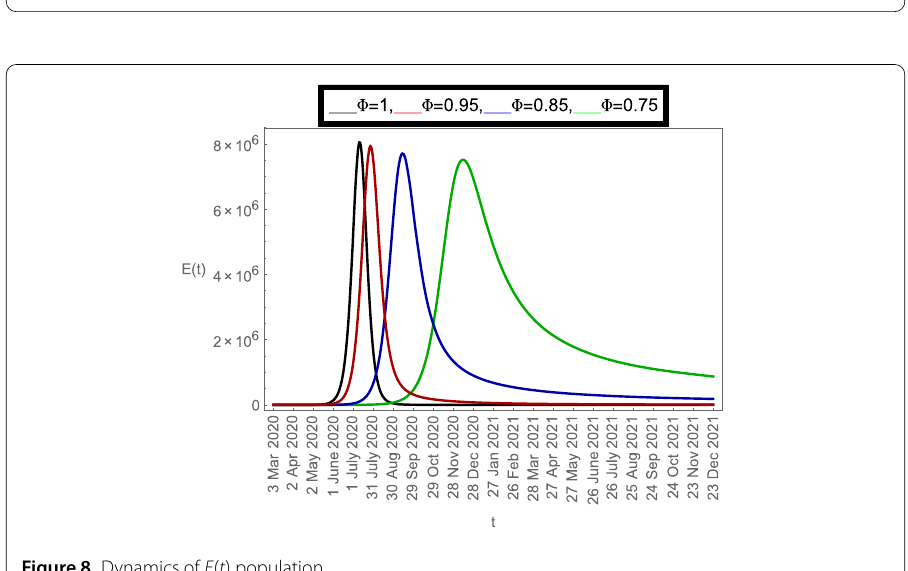
Figure 8 Dynamics of E ( t ) population